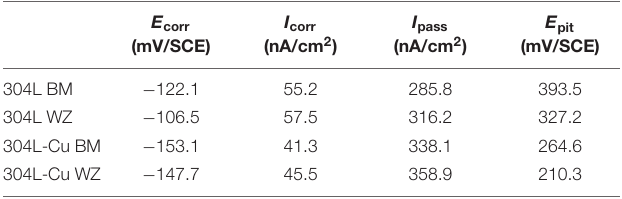
Frontiers in Materials |